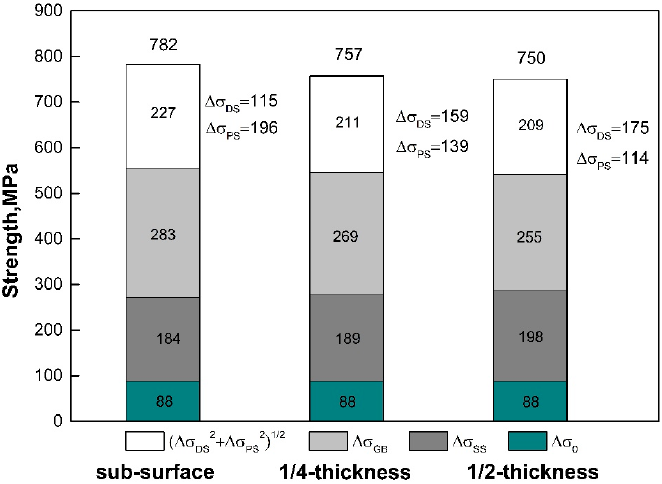
Figure 15. Strengthening components evaluated for the varied thickness positions of the steel.